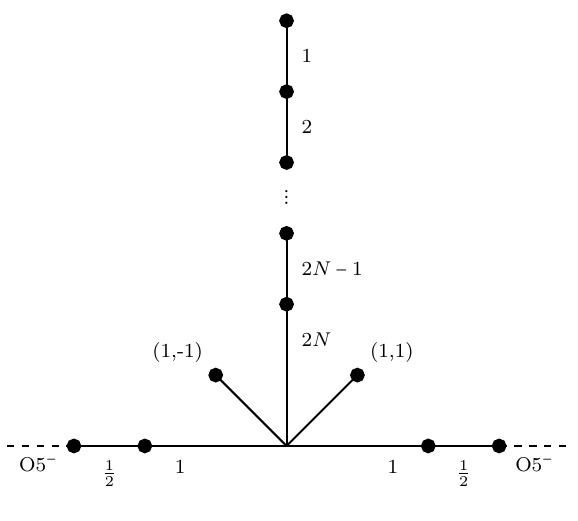
Figure 3. Orientifold web for EQ 3 , 3